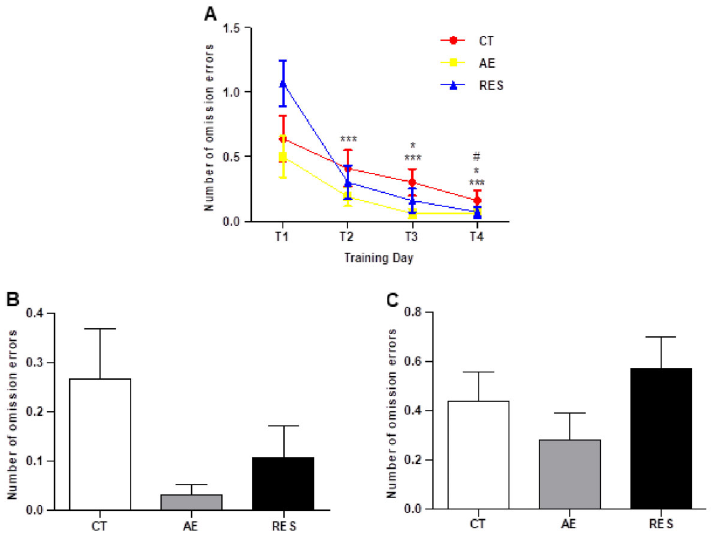
Figure 4. Number of omission errors during the training days (T1-T4) of the modi fi ed hole board test ( A ). *P o 0.05 compared to the fi rst training day of the AE group; ***P o 0.001 compared to the fi rst training day of the RES group; # P p 0.05 compared to the fi rst training day of the CT group (repeated-measures one-way ANOVA followed by Tukey ’ s post hoc ). The number of omission errors was measured in the location shift phase ( B ) and the reversal phase ( C ) of the task (one-way ANOVA). Data are reported as means ± SE (n=14 – 16 per group). CT: sedentary control; AE: aerobic exercise on the treadmill; RES: resistance exercise on the ladder apparatus.